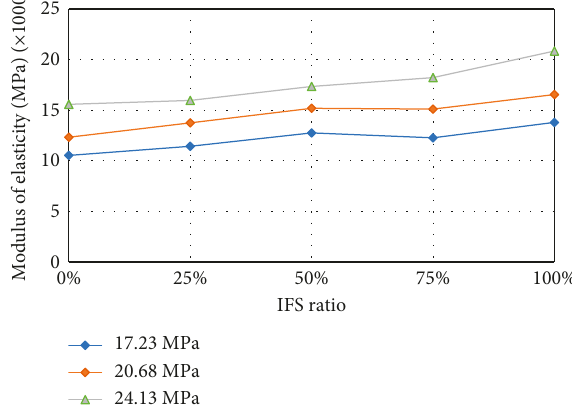
Figure 23: Modulus of elasticity of concrete for different IFS ratios.